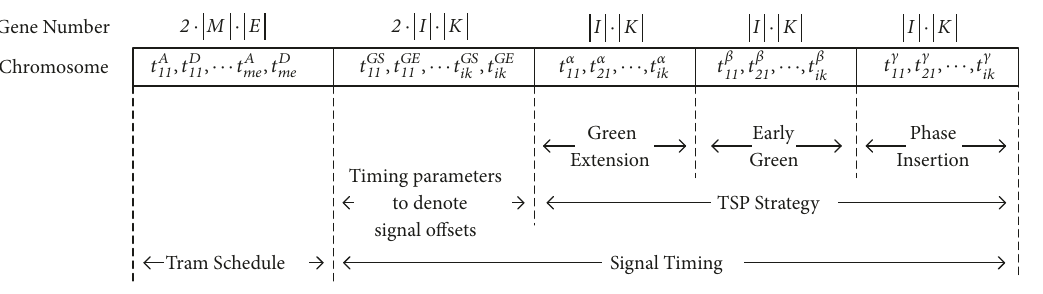
Figure 4: Chromosome